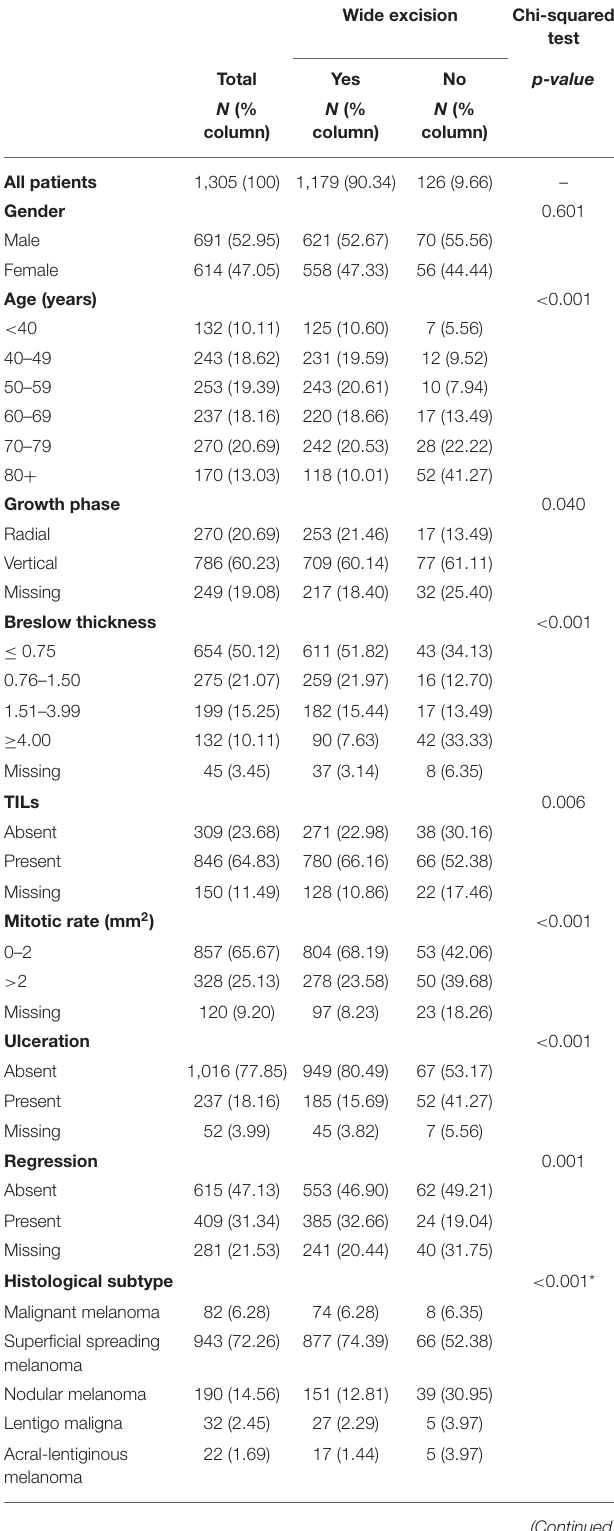
TABLE 1 | Demographics and pathology of patients with cutaneous malignant melanoma (CMM) who did or did not undergo wide local excision (TILs, tumor infiltrating lymphocytes; TNM, CMM